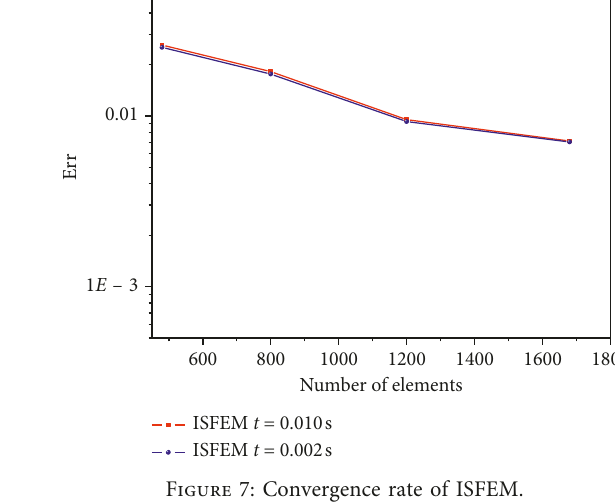
Figure 7: Convergence rate of